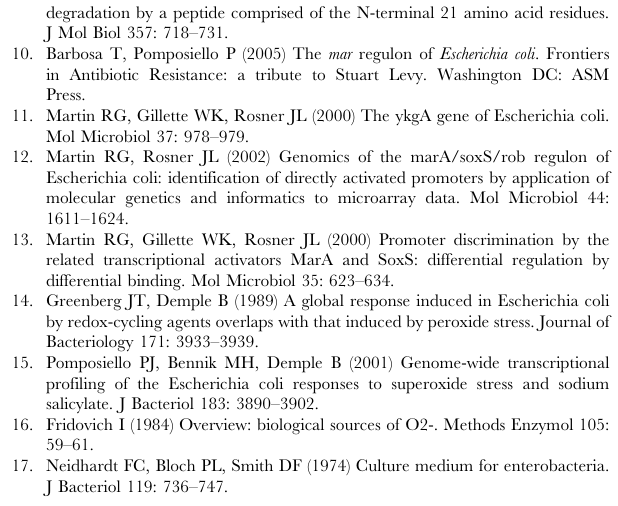
genes identified by